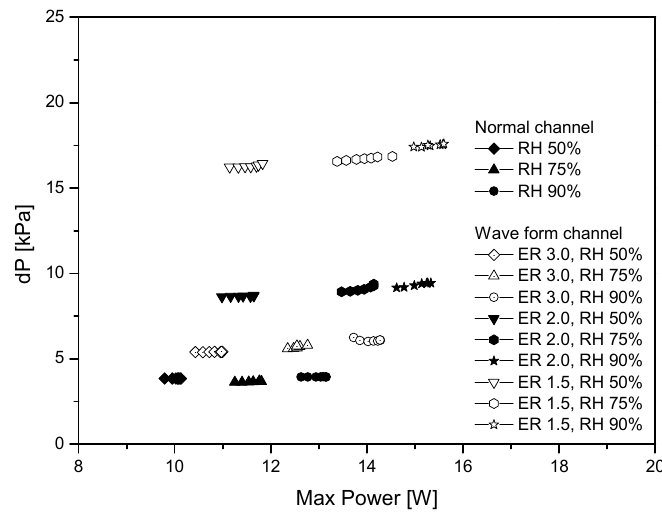
Figure 11. Pressure difference between the normal channel and wave form channel with varied ER.